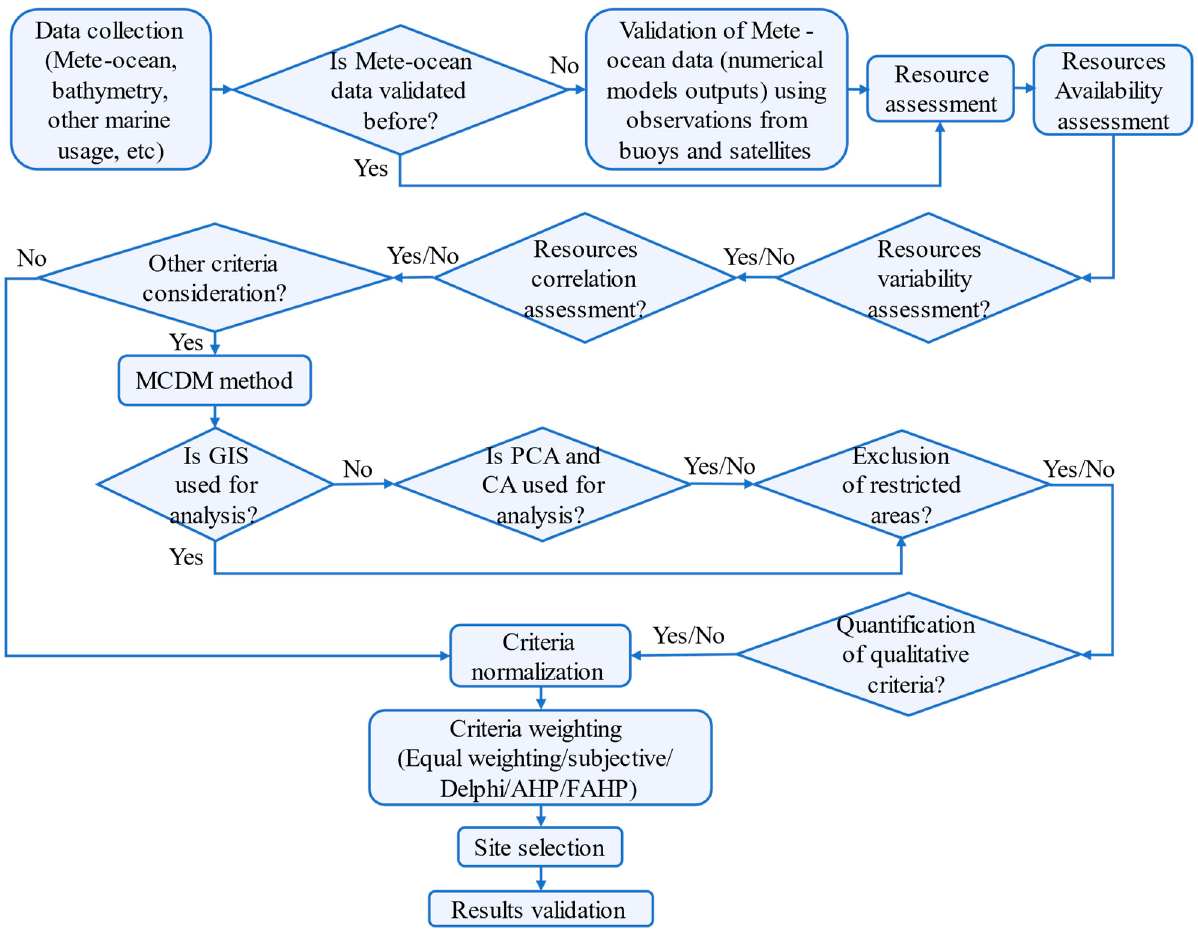
Figure 5. Flow diagram of methodologies used for combined offshore wind–wave energy farm site selection. Table 3. COWWEF site selection analytical methods used in the literature.